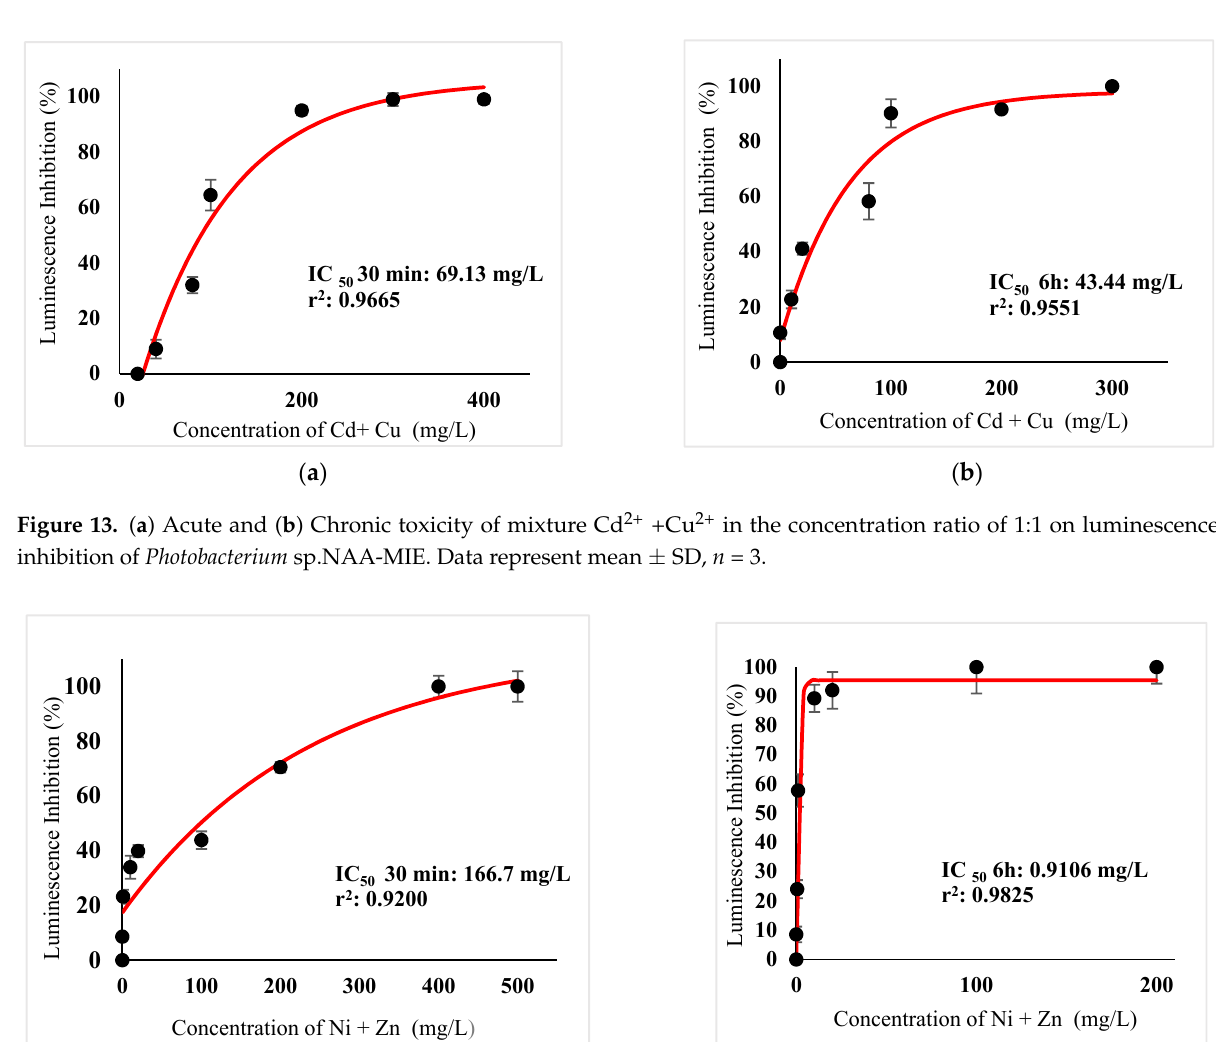
Figure 12. ( a ) Acute and ( b ) Chronic toxicity of mixture Cu 2+ + Zn 2+ in the concentration ratio of 1:1 on luminescence inhibition of Photobacterium sp.NAA-MIE. Data represent mean ± SD, n = 3.